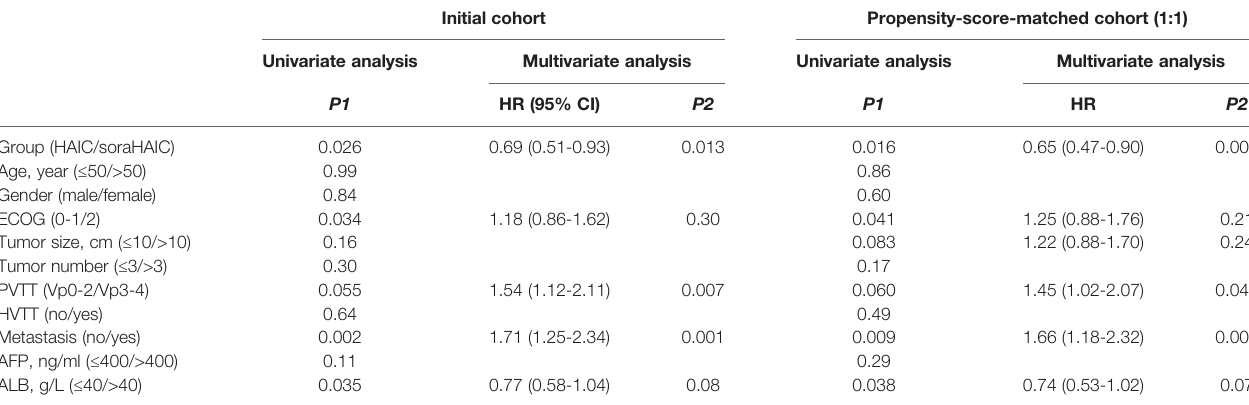
TABLE 2 | Univariate and multivariate analysis of overall survival in initial and propensity-score-matched cohorts. Initial cohort Propensity-score-matched cohort (1:1)